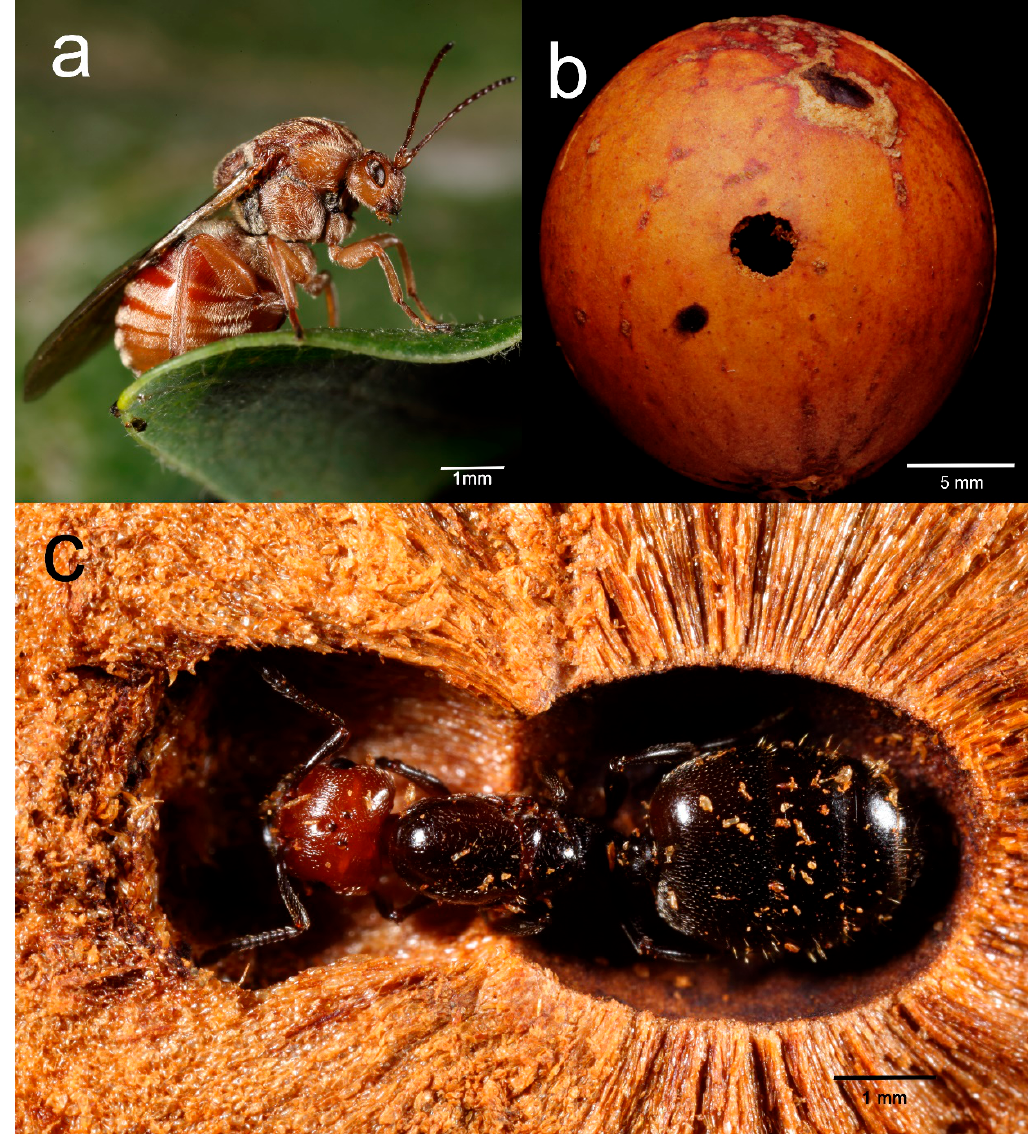
Figure 1. ( a ) A. kollari (Hymenoptera: Cynipidae) and the induced oak-gall ( b ); ( c ) a queen of Crematogaster scutellaris inside the gall of A. kollari during the first phase of gall colonization and colony founding.